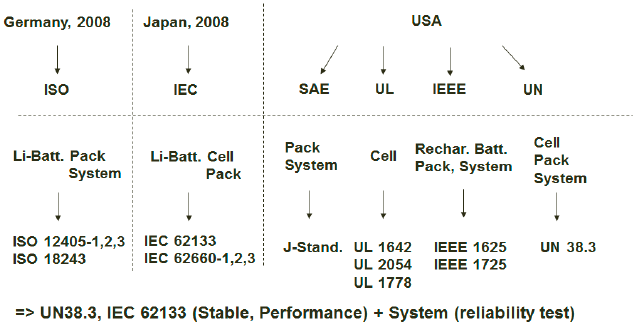
Figure 1. International standards for lithium batteries.